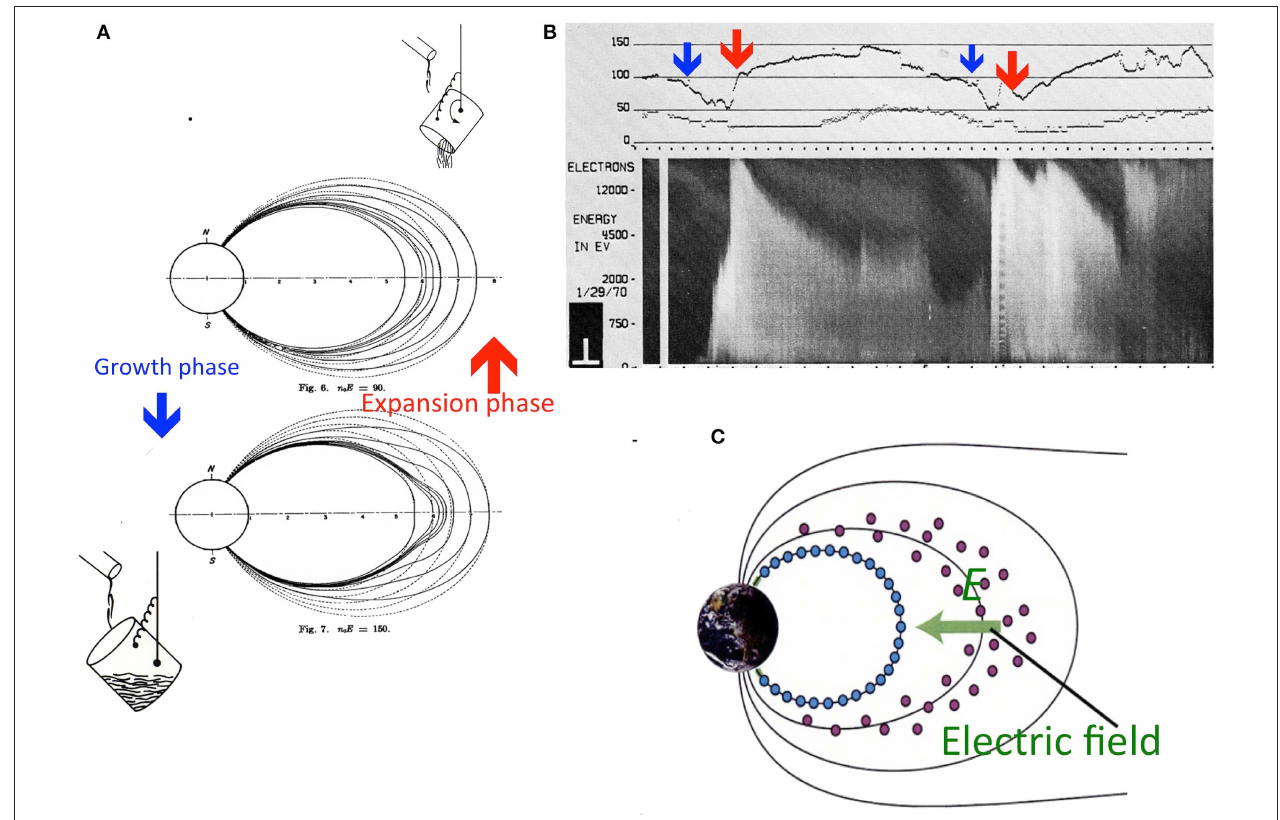
FIGURE 11 | Auroral substorms (modified from Akasofu, 2019). (A) It shows the inflation (the growth phase, blue arrow) by the power accumulation and deflation (the expansion phase, red arrow) by unloading of the energy. (B) Satellite observations at the geosynchronous distance (6 Re) (courtesy of C. E. McIlwain). The magnetic field decreases during the inflation (blue arrow), and the deflation causes an increase of the magnetic field (red arrow). The double layer along the field-aligned current [the three-dimensional (3D) unloading (UL) current system in Figure 12A ] accelerates electrons, indicating the occurrence of substorms (as can be seen in the lower part). (C) A schematic illustration how the deflation might cause the charge separation and the earthward electric field which generates the UL 3D current system (electrons in blue and protons in